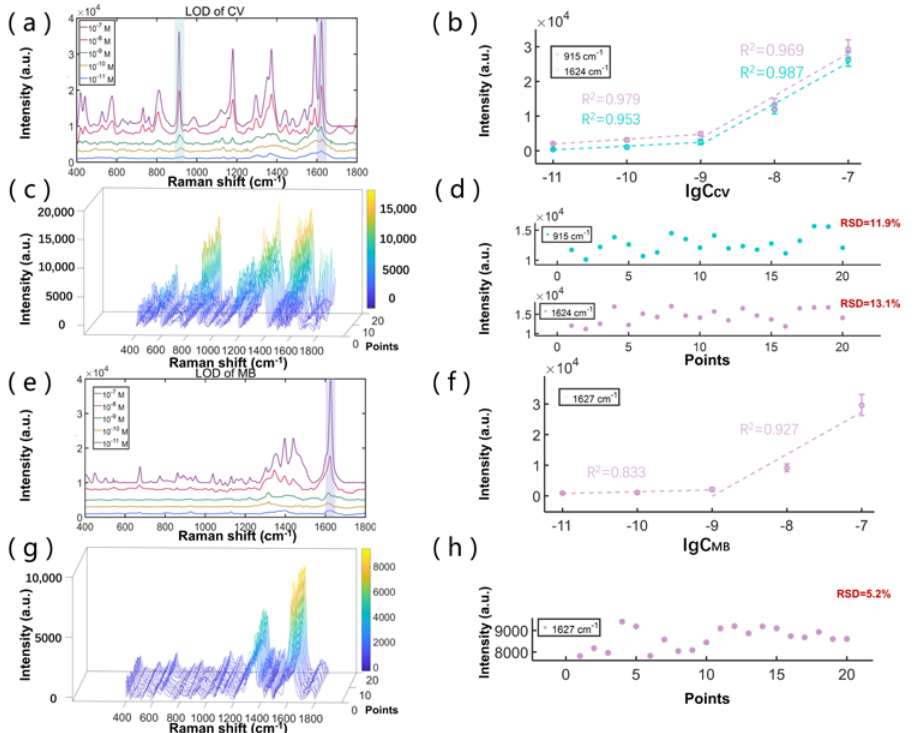
Figure 3. ( a ) SERS signals from dynamically enriching 13 μL droplet (10 μL CV solution and 3 μL Ag colloid) with different concentrations; (b) the data for SERS intensity peaks at 915 cm −1 and 1624 cm −1 versus the CV concentration; ( c ) SERS signals of 10 − 8 M CV/AgNPs from 20 random positions based on SCDA dynamic enrichment mode; ( d ) the data for CV SERS intensity at 915 cm −1 and 1624 cm −1 from 20 random positions; ( e ) SERS signals from dynamically enriching 13 μL droplet (10 μL MB solution and 3 μL Ag colloid) with different concentrations; ( f ) the data for SERS intensity peaks at 1627 cm −1 versus the MB concentration; ( g ) SERS signals of 10 −8 M MB/AgNPs from 20 random positions based on SCDA dynamic enrichment mode; ( h ) the data for MB SERS intensity at 1627 cm −1 from 20 random positions.